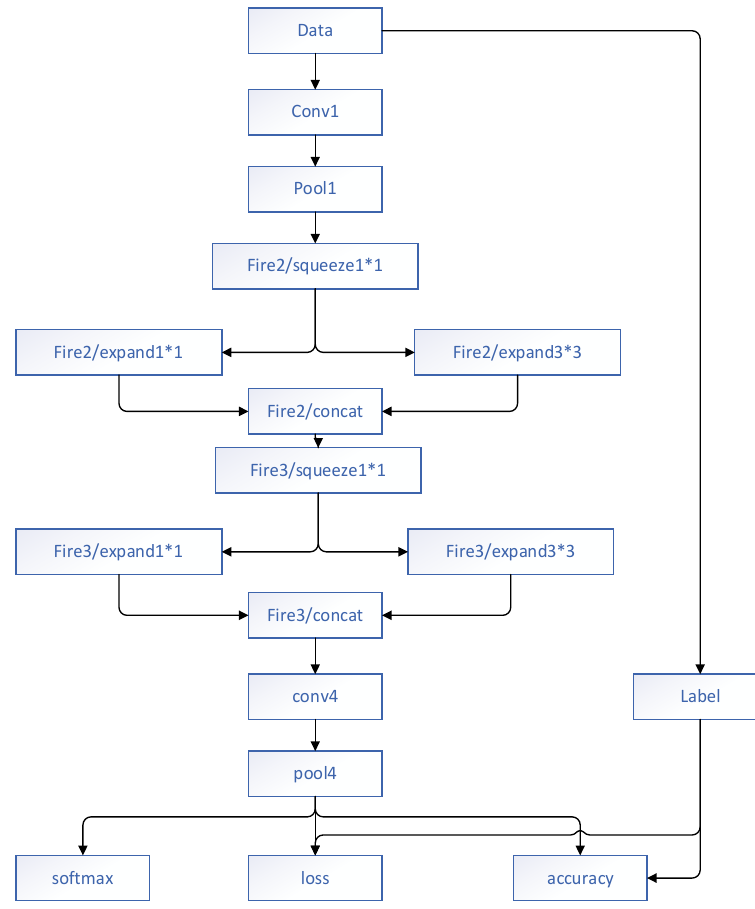
Figure 4. Architecture of the Gastric Precancerous Disease Network (GPD Net) proposed by Zhang et al. [8]. Zhang et al.